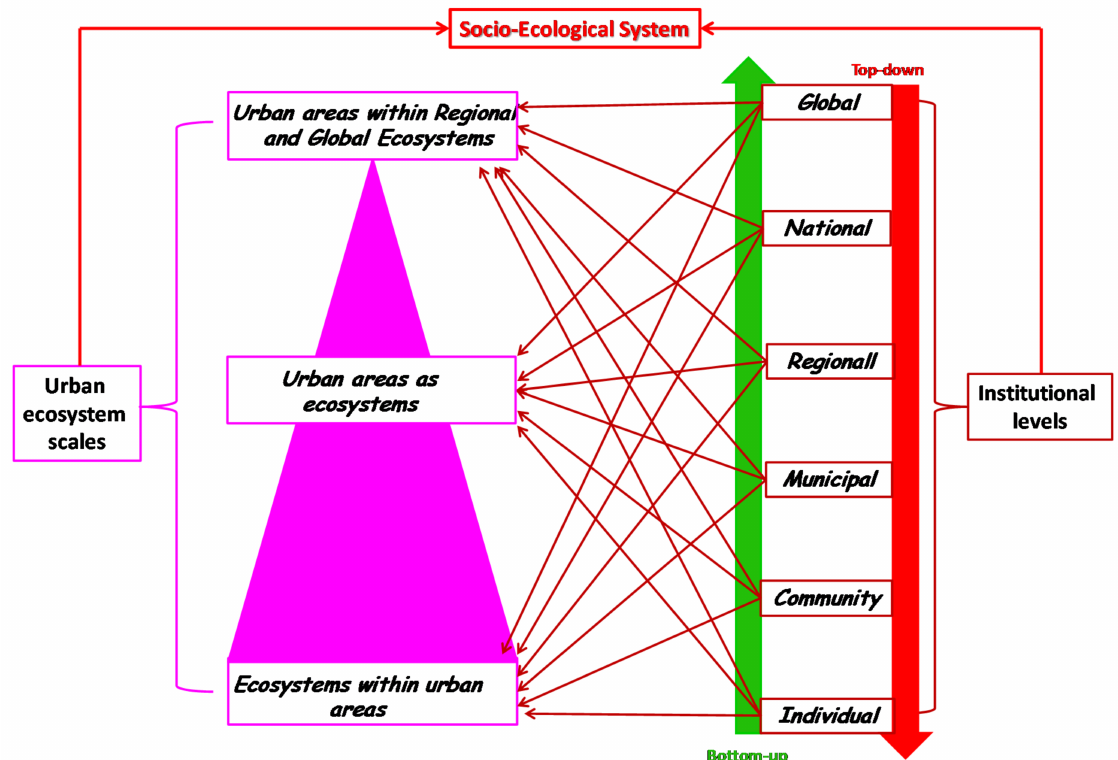
Figure 1. Schematic representation of the relationship between urban ecosystem scales and institutional levels in the socio-ecological system